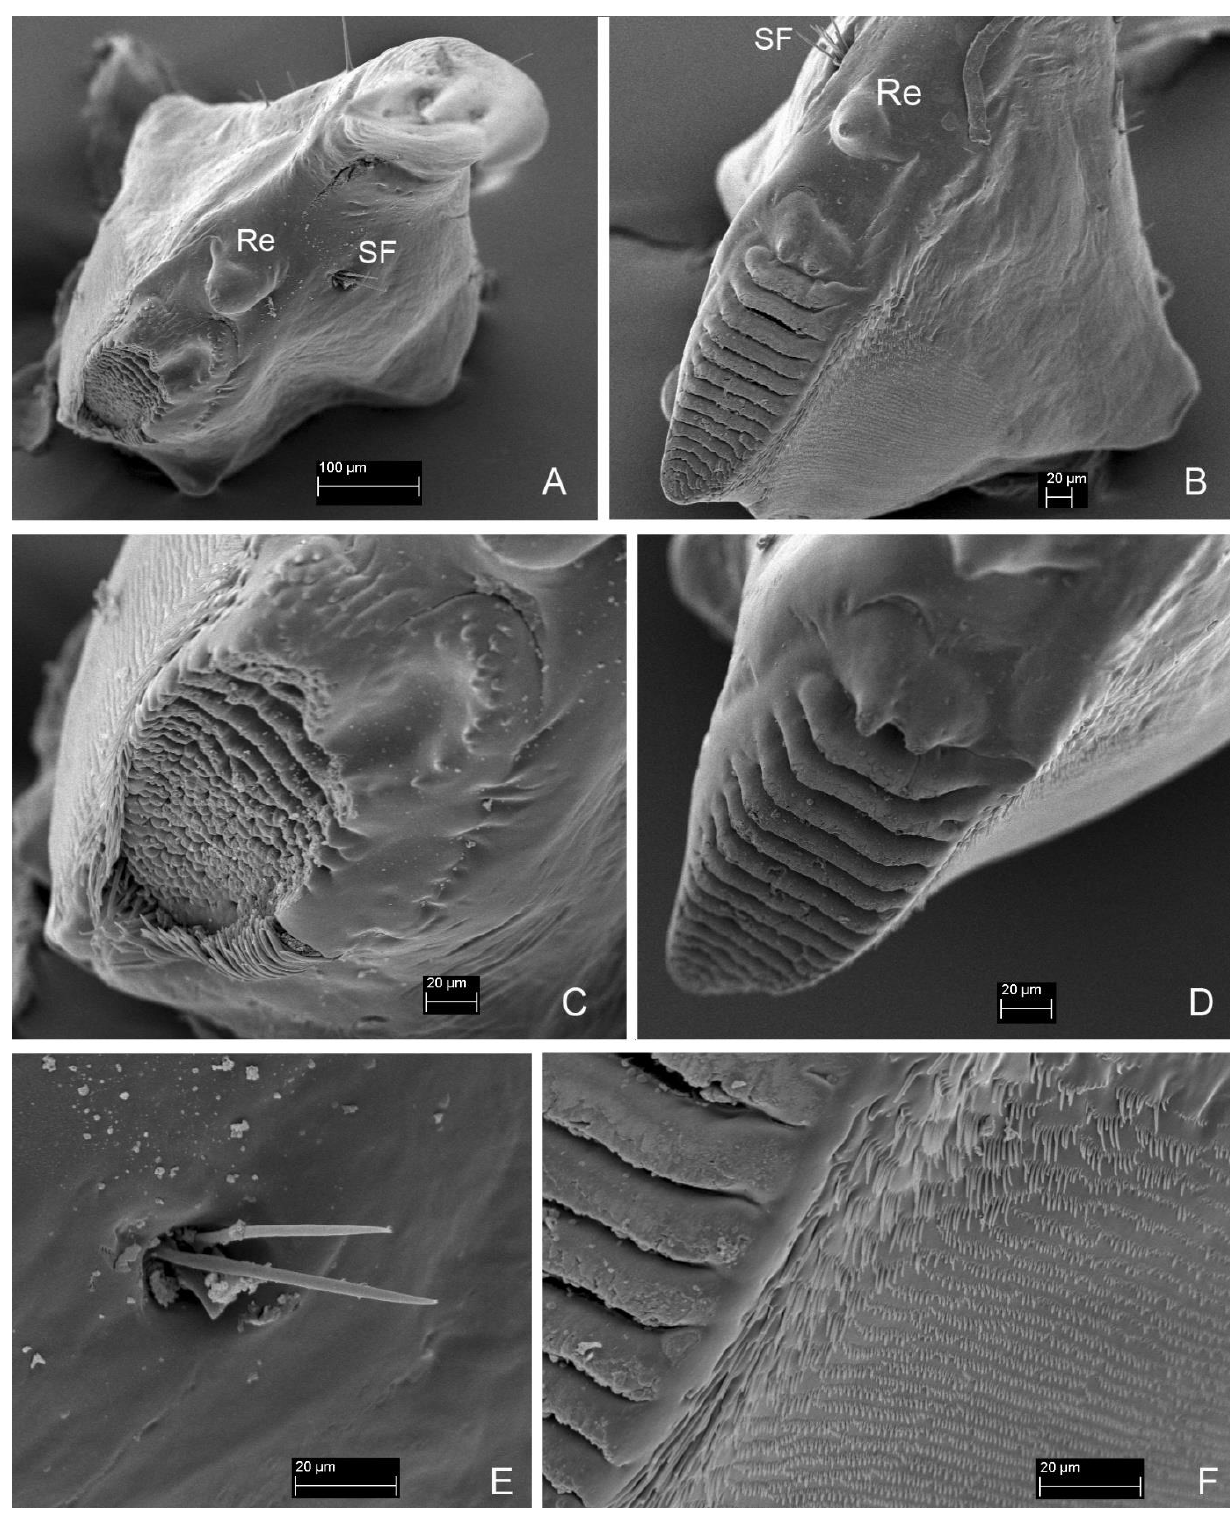
Figure 10. Leiodes cinnamomea . Details of larval morphology of instar III. Mandible. ( A ) Left. ( B ) Right. ( C ) Left, mola and retinaculum. ( D ) Right, mola and retinaculum. ( E ) Setal field. ( F ) Rigth, details of transverse ledges and rows of microtichia. Abbreviations: Mo—mola; Re—retinaculum; SF—setal field.